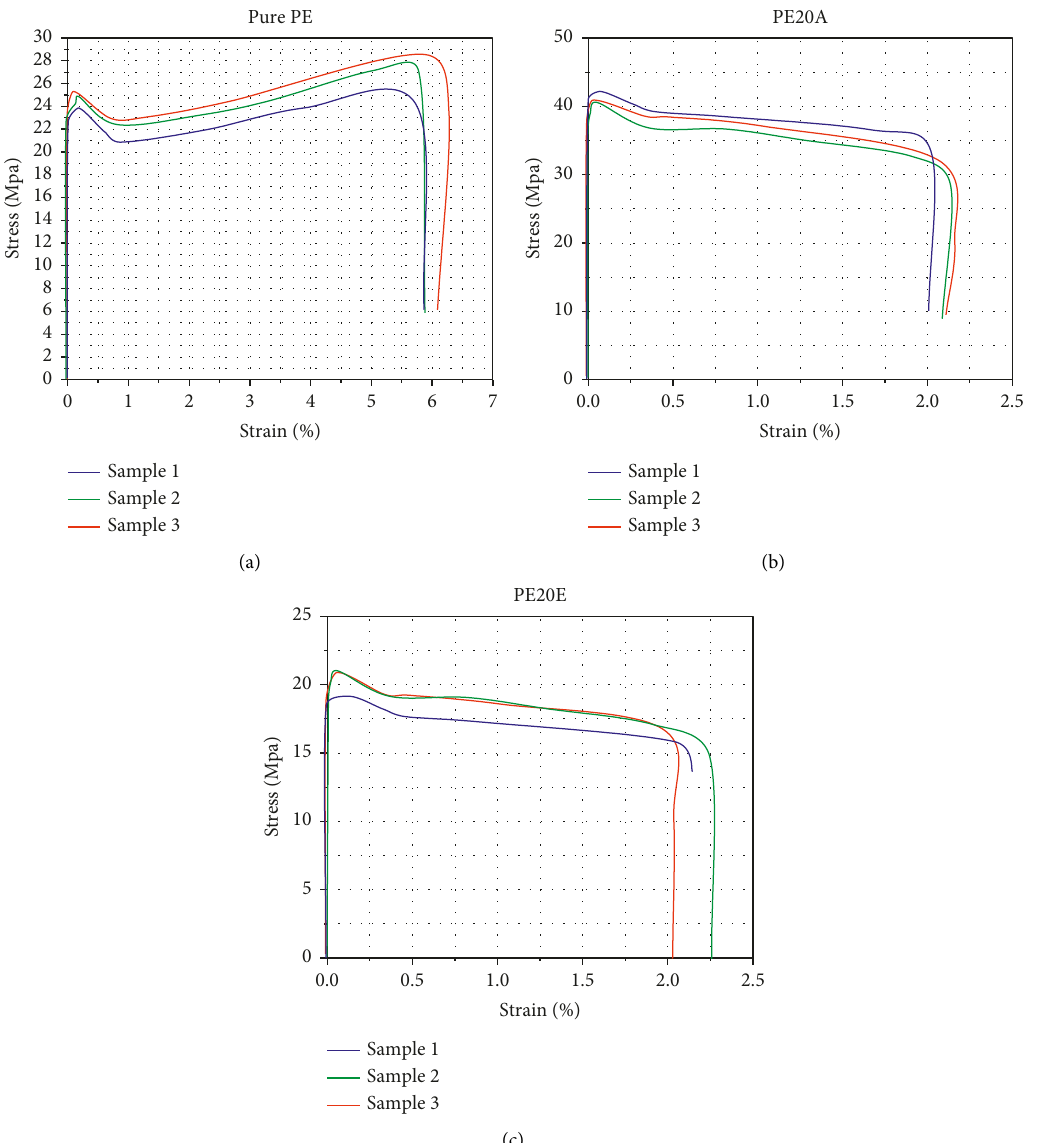
Figure 3: Stress-strain curve samples for (a) pure polyethylene, (b) polyethylene containing 20 wt percent of iron oxide with grade A particle size, and (c) polyethylene having 20wt percent of iron oxide with grade E particle